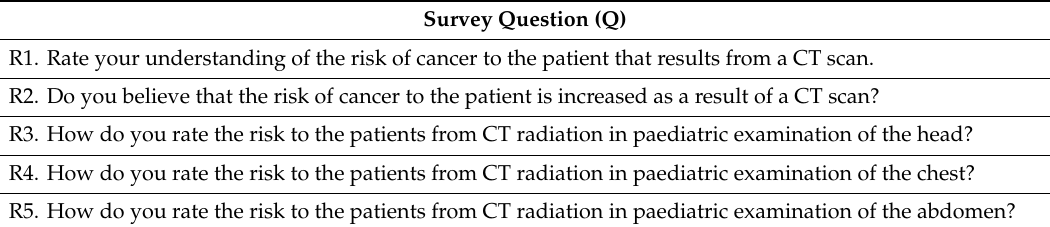
Table 1. Survey questions for the evaluation of radiologists’ knowledge of computed tomography (CT) radiation dose risk in paediatric examinations.